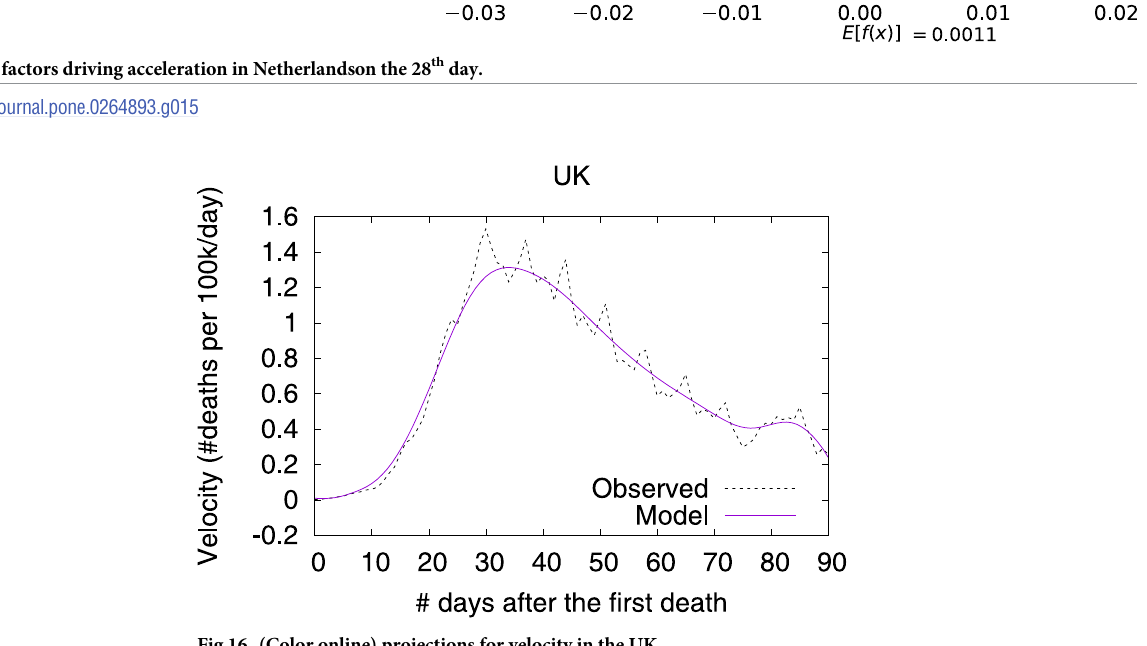
Fig 16. (Color online) projections for velocity in the